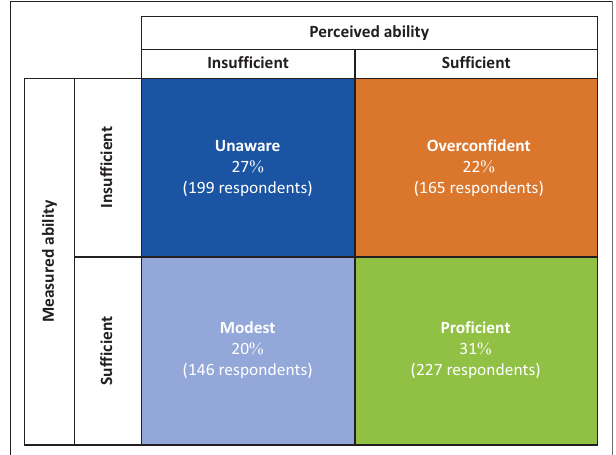
FIGURE 10: Classification of respondents as unaware, overconfident, modest or proficient after comparing their measured ability with their perceived